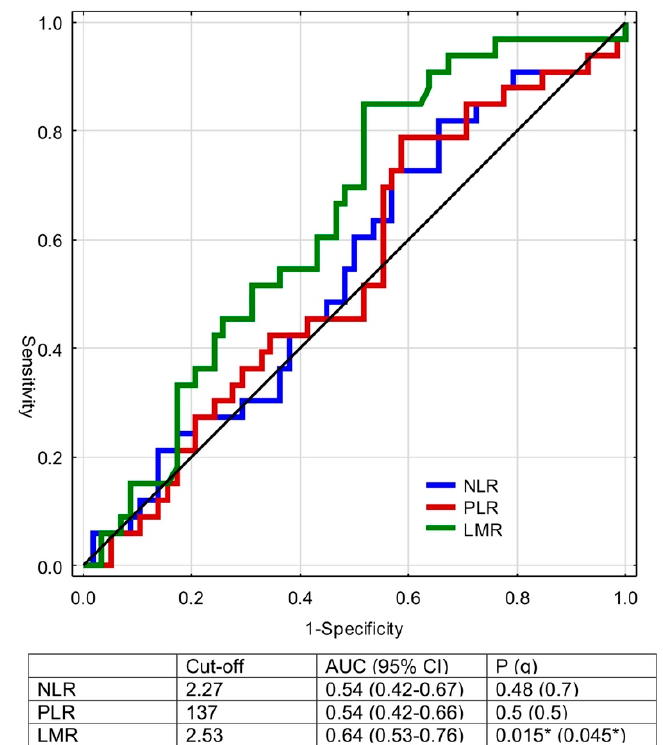
Figure 2. Receiver operating curves for NLR, LMR, PLR, versus event (death). Q values were calculated